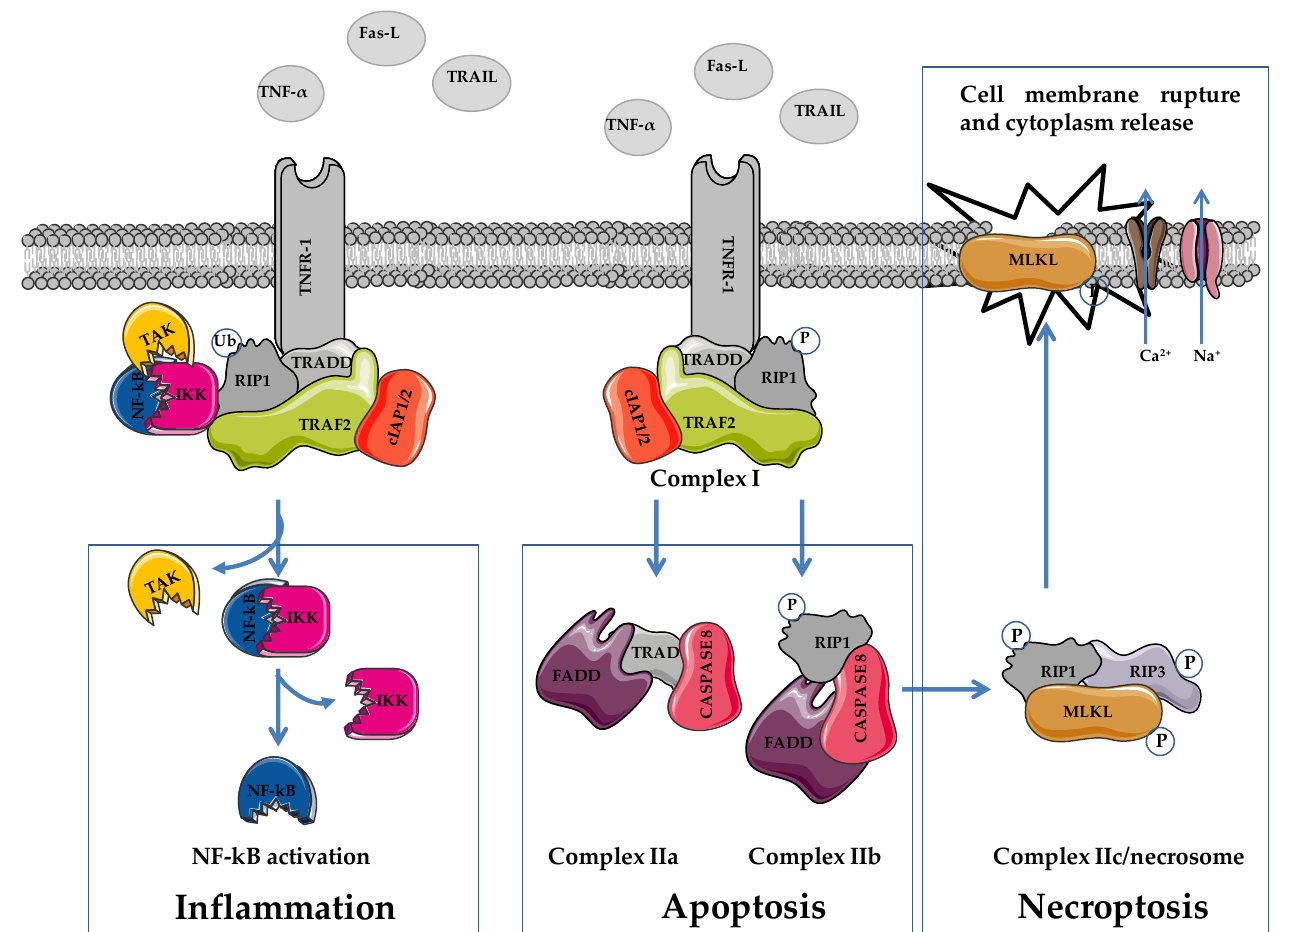
Figure 1. Schematic representation of cellular pathways involved in necroptosis. TNF- α , tumor necrosis factor α ; FasL, Fas ligand; TRAIL, TNF-related apoptosis-inducing ligand; TNFR1, TNF receptor 1; RIP1/3, receptor-interacting serine/threonine-protein kinase 1/3; MLKL, mixed lineage linase domain like pseudokinase; TRADD, TNF receptor associated death domain protein; FADD, Fas-associated death domain; TRAF2, TNF receptor associated factor 2; cIAP1/2, cellular inhibitor of apoptosis proteins 1/2; TAK complex formed by TAK1, TAB2 and TAB3; IKK complex, formed by IKK α and IKK β . Figure was prepared using tools from Servier Medical Art (http://www.servier.fr/servier-medical-art, accessed on 15 March 2022). Table 1. Comparison of necroptosis-, necrosis-, and apoptosis-regulated cell death properties.